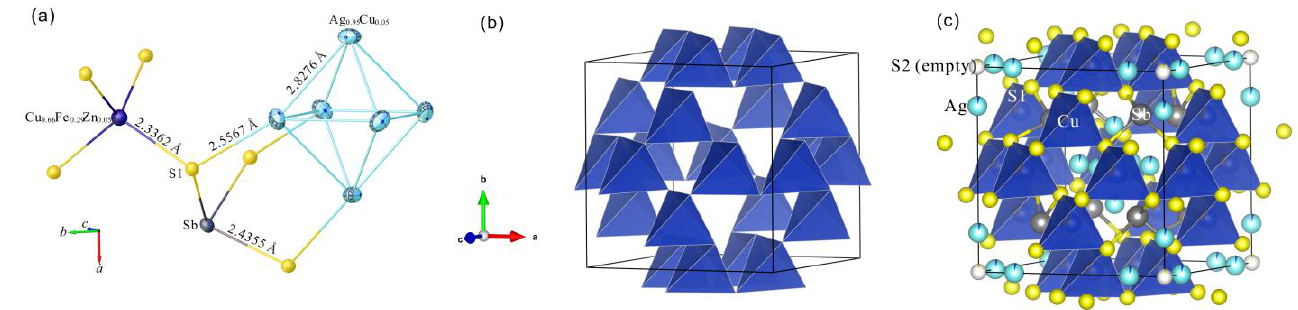
Figure 3. The crystal structure of kenoargentotetrahedrite-(Fe): ( a ) showing anisotropic ellipsoids, connectivity and bonding lengths of atoms; ( b ) showing the cage within the cube formed from the distribution of M (1)S 4 tetrahedra on the six faces of the unit-cell cube; ( c ) showing the distribution of SbS 3 pyramid and Ag 6 cluster in the cage of M (1)S 4 tetrahedra, with the S(2) site being empty.